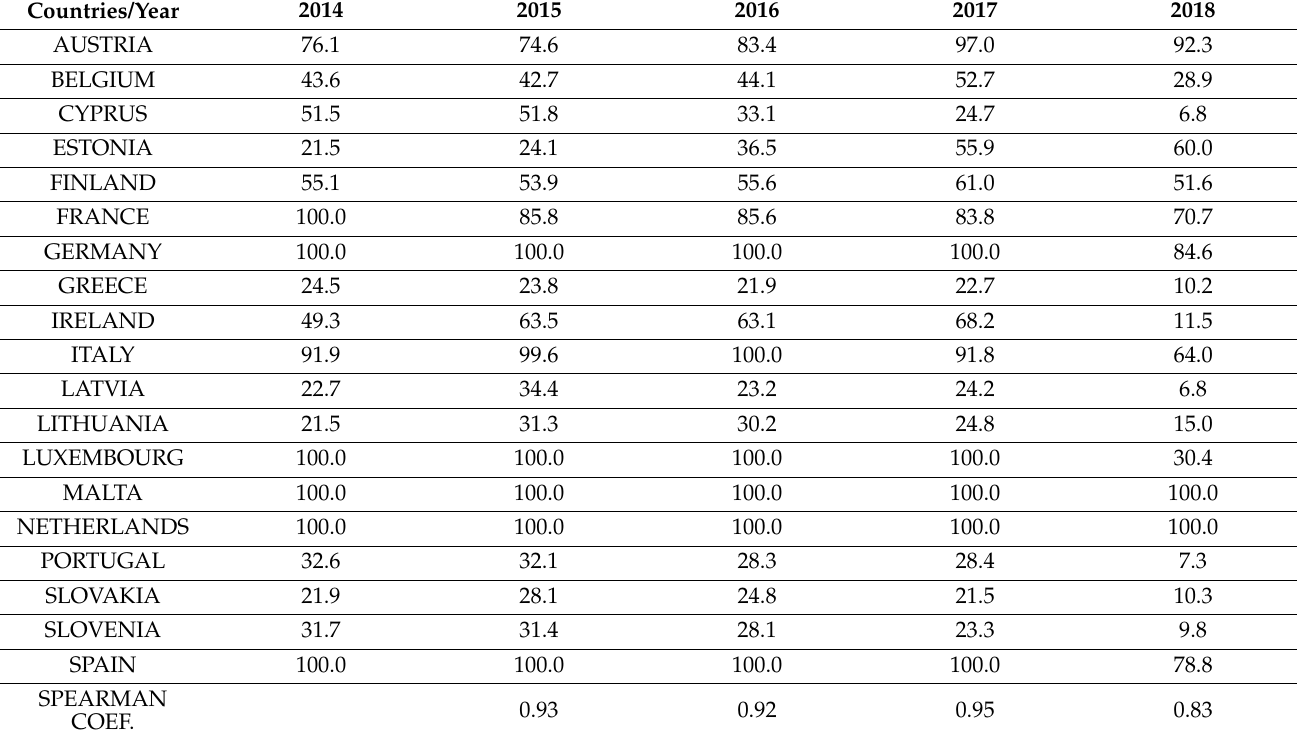
Table 4. Relative efficiency of the countries of the Eurozone